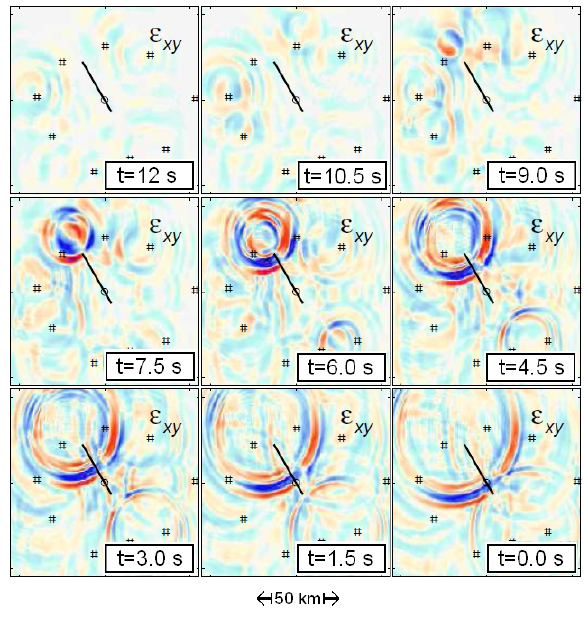
Fig. 9. Snapshots of the time-reversed strain component (cid:15) xy at 12 . 5km depth for the 9 sub-arrays composed of 4 receivers each. The fault trace is indicated by the black line. All snapshots are shown in the same amplitude range.